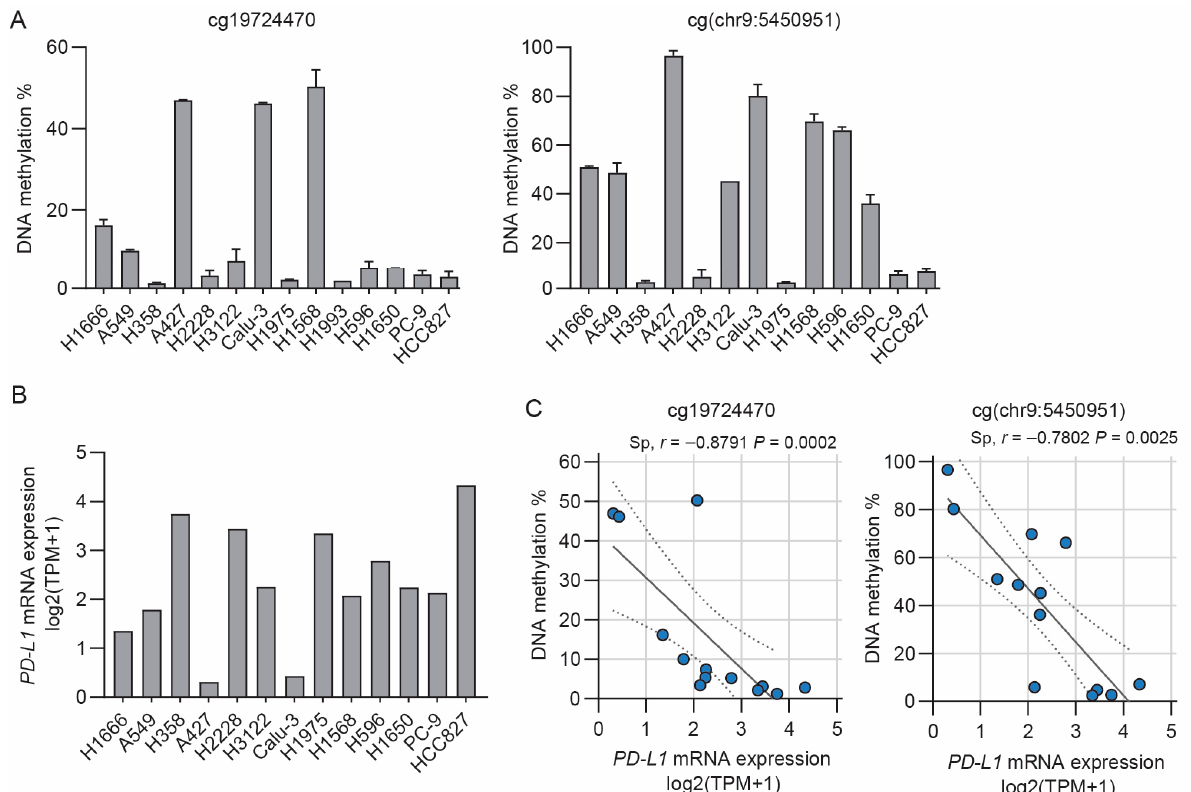
Figure 1. PD-L1 methylation and mRNA expression in NSCLC cell lines. ( A ) DNA methylation of cg19724470 (left panel) and cg(chr9:5450951) (right panel) in NSCLC cell lines. Mean ± SD of at least two PCR-pyrosequencing runs. For cg(chr9:5450951), H1993 is not included, as we could not successfully quantify the DNA methylation at this site. ( B ) PD-L1 mRNA expression in NSCLC cell lines from the Expression 22Q2 Public dataset derived from DepMap Portal. The DepMap Portal contained no information on the H1993 cell line at the time of the analyses. Transcripts per million (TPM). ( C ) Correlation analysis of PD-L1 mRNA expression from the DepMap Portal and DNA methylation of cg19724470 (left panel) and cg(chr9:5450951) (right panel) in NSCLC cell lines. Spearman’s correlation coefficients ( r ) and the p -values are depicted above the graphs. Linear best fit (solid line) and 95% confidence intervals (dotted lines) are